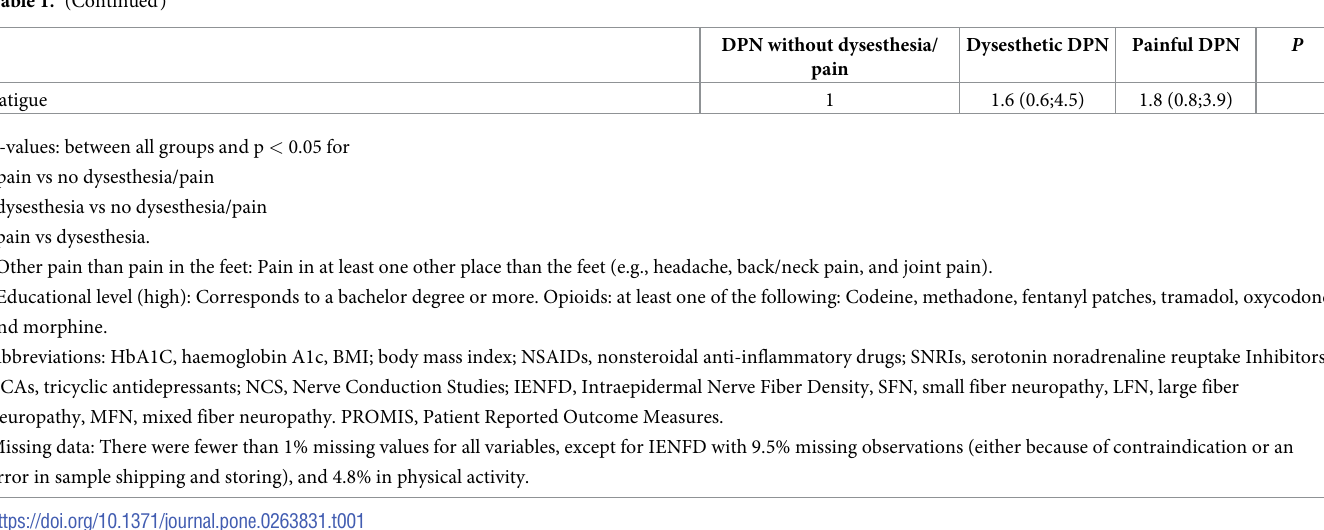
without dysesthesia/pain. Patients with dysesthesia and pain also had higher fatigue scores than patients without dysesthesia/pain, although there was no difference in the percentages with mild, moderate, or severe interference (Table 1). Most patients had experienced dysesthesia or pain for 1–5 years and around 40% for more than 5 years as compared to the median time from diabetes diagnosis of around 6 years. The average intensity of pain was higher than the average intensity of dysesthesia (Table 2). Pain interfered more often with activities of daily life than dysesthesia (68% vs 38% with mild to severe interference, P = 0.005).